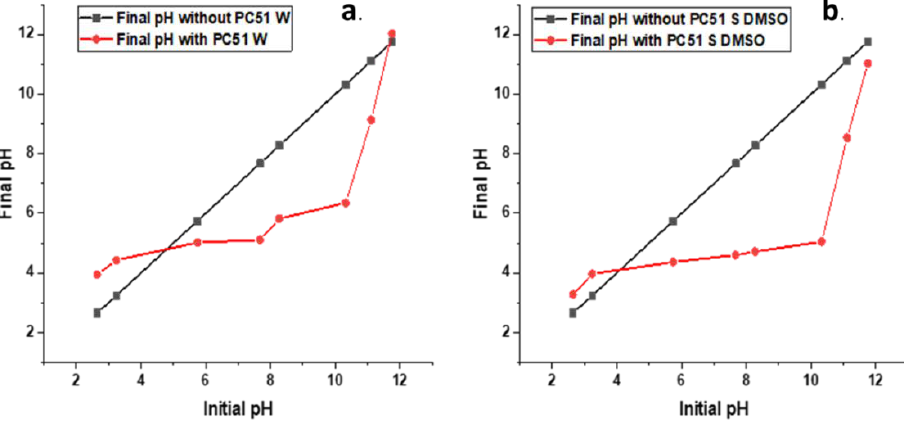
Figure 1. Point-of-zero charge (PZC) results of pectin and chitosan composites: ( a ) water-based synthesis; ( b ) dimethyl sulfoxide-based synthesis.